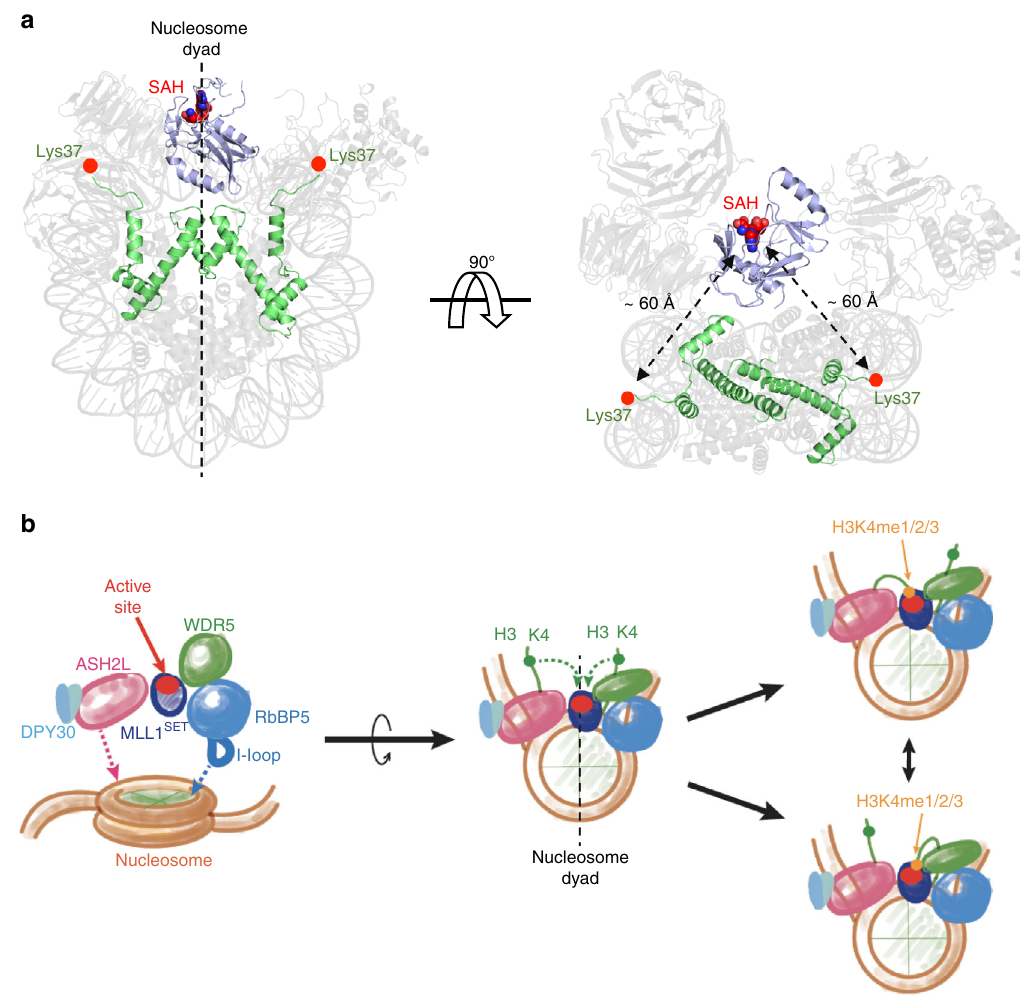
Fig. 6 The MLL1 SET domain aligns at the nucleosome dyad. a MLL1 SET (slate) and two copies of histone H3 (green) were highlighted against the faded MLL1 RWSAD -NCP structure. The SAH molecule represented as a sphere and marked the catalytic active site of MLL1 SET . b Schematic model of NCP recognition mediated by the MLL1 core complex. The I-loop of RbBP5 and the active site of MLL1 SET were colored in blue and red,